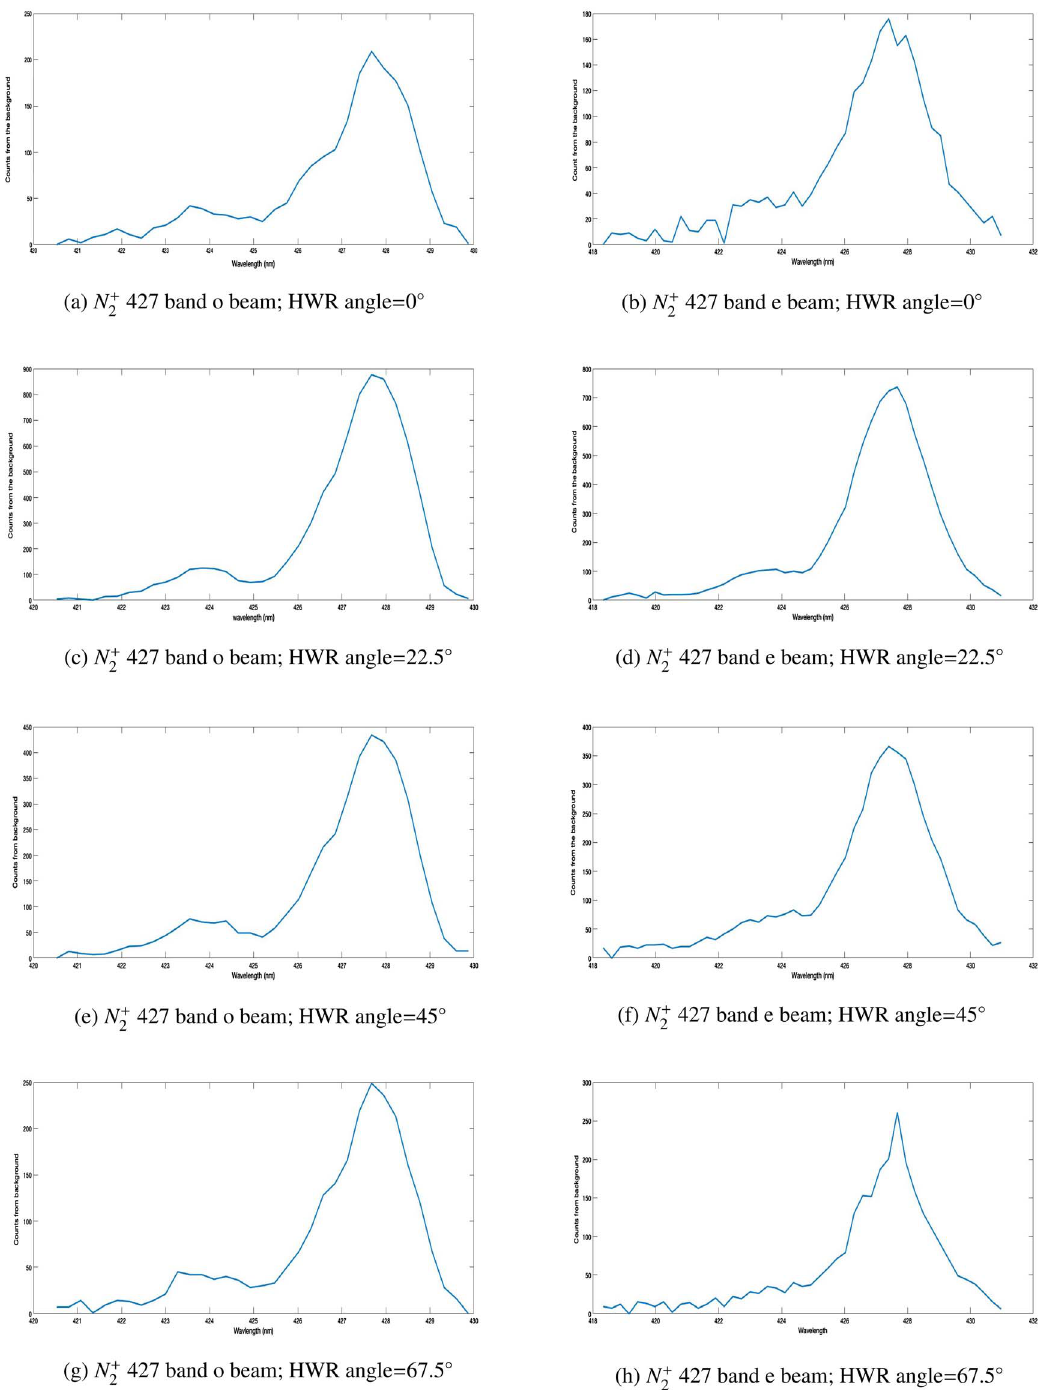
Fig. 6. Extracted blue line pro fi le after background subtraction and cosmic rays traces removal for the data set taken March 2nd 2017 from 19:35 to 20:20. Both o (Left panels) and e (Right panels) beams are shown. Extraction is done using the method previously described in the paper. Integration is done using the shown pro fi le. The line peak is at 427.8